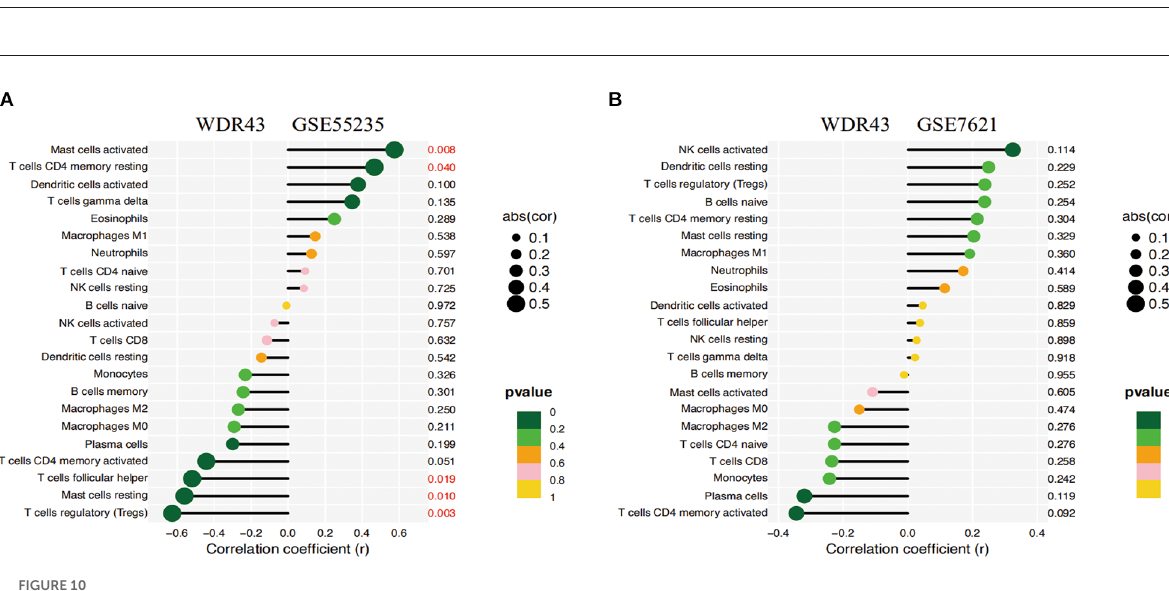
We found differential expression of a variety of immune cells through immune infiltration in OA and PD, suggesting